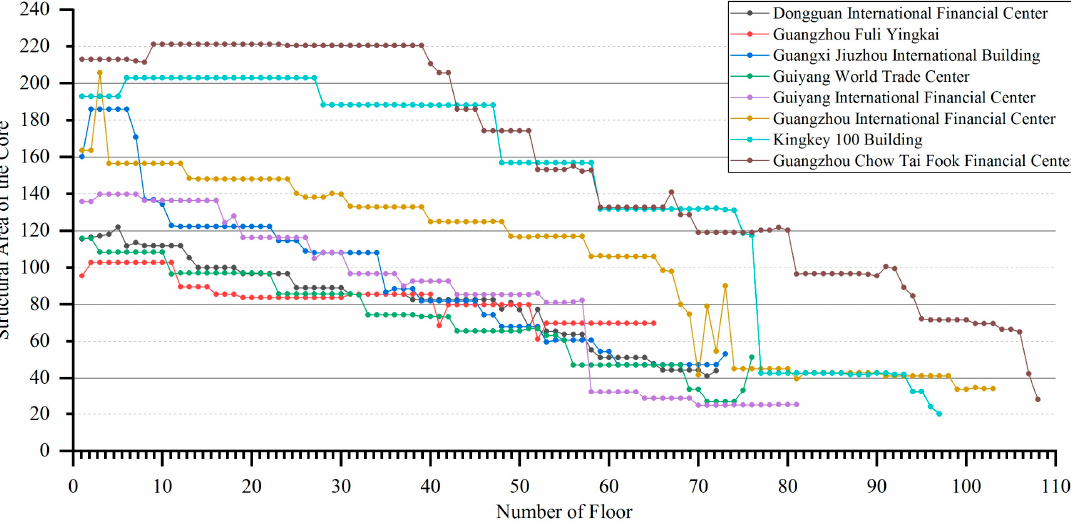
Figure 17. The structural area of the core.